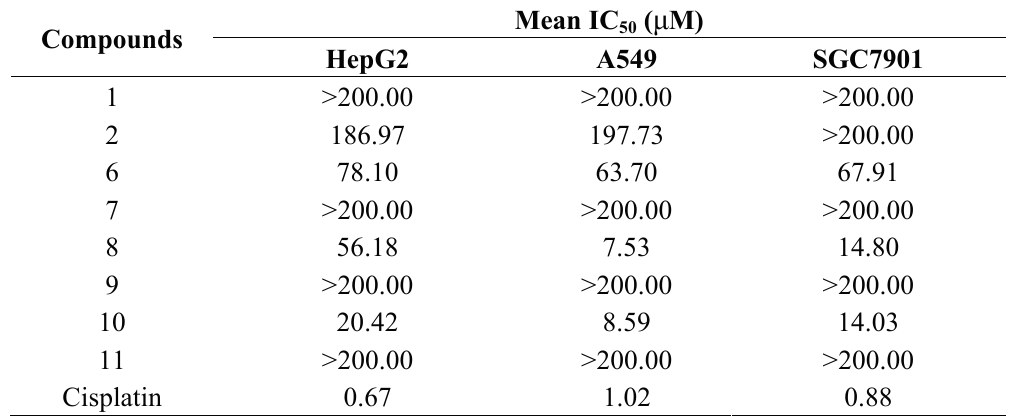
Table 1. Anticancer activities of the key isocorydine derivatives on three common human cancer cell